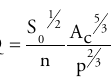
: bottom algae, a : phytoplankton, m : b p o : organic nitrogen, n : ammonia ni- o a